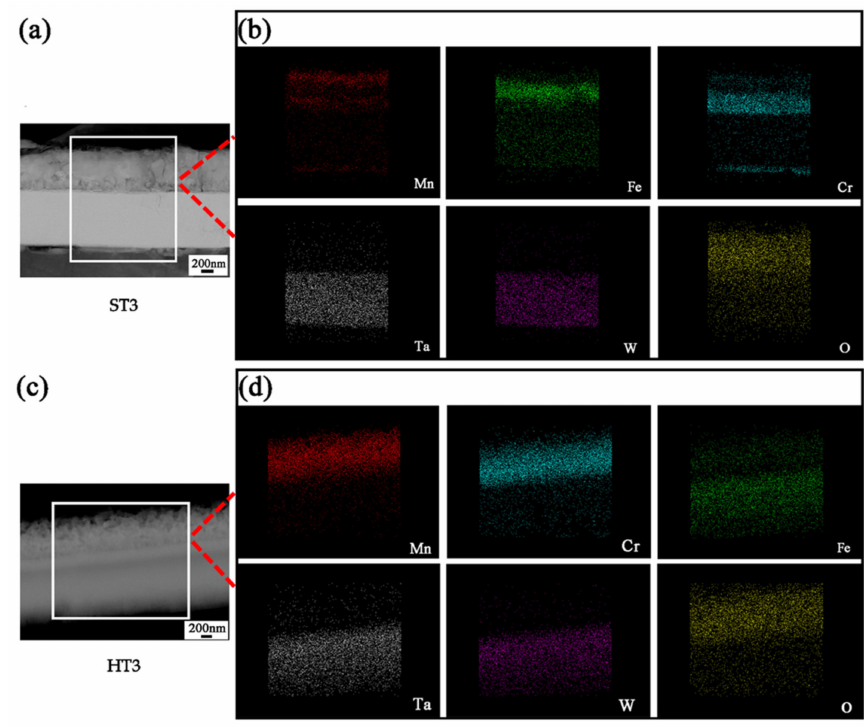
Figure 7. ( a ) The cross-sectional HAADF image of ST3 sample; ( b ) The EDS–mapping image of ST3 sample; ( c ) The cross-sectional HAADF image of HT3 sample; ( d ) The EDS–mapping image of HT3 sample.